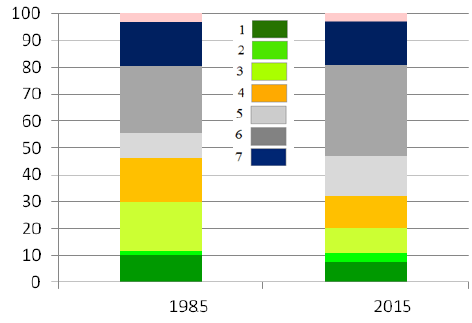
Figure 4. Percentage of each UST (colors) in the study area in 1985 and